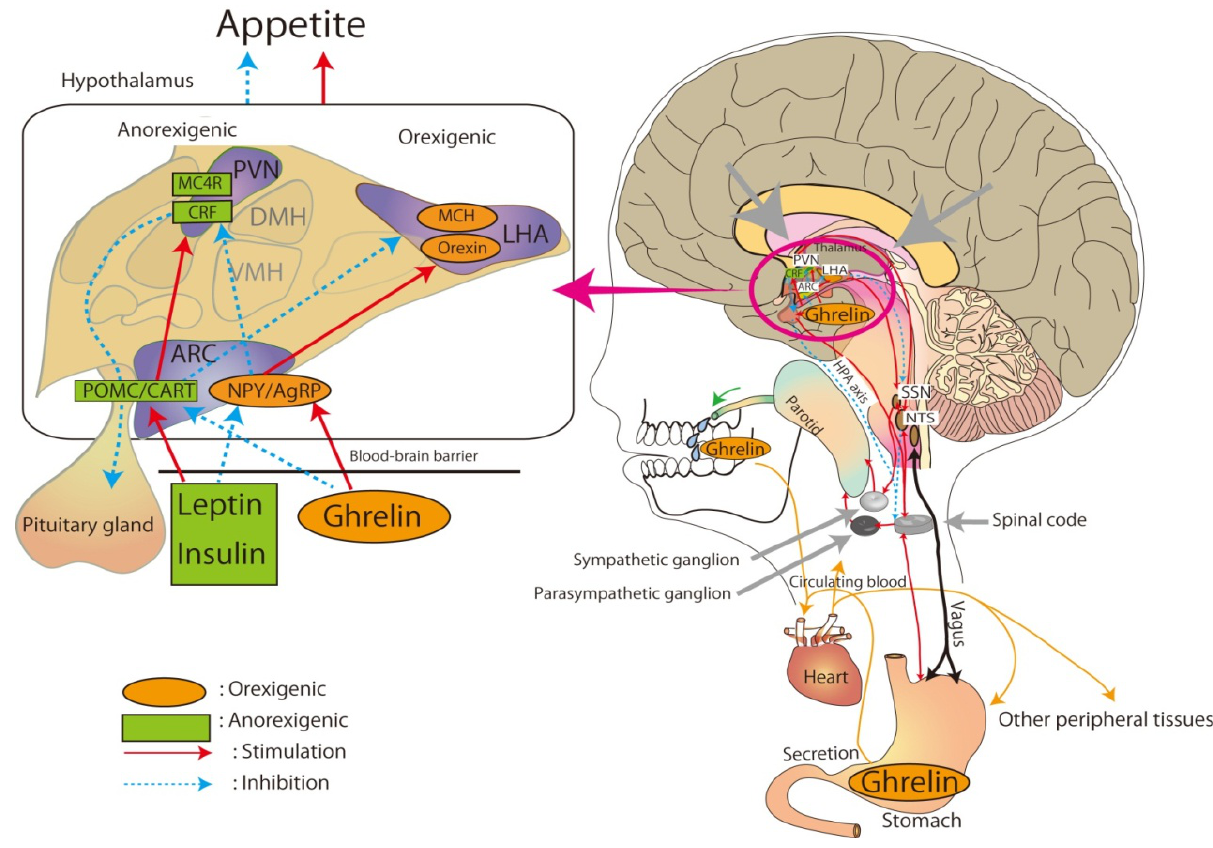
Figure 2. Feeding regulation of neuroendocrine hormones and salivary secretion. Salivary secretion is stimulated through the parasympathetic and sympathetic ganglia. The parasympathetic ganglion receives a stimulus from the nucleus of the solitary tract (NTS), and the sympathetic ganglion receives input from the NTS via the spinal cord. Both ganglia regulate salivary secretions. The parotid salivary glands supply ghrelin. Ghrelin circulates and spreads throughout the human body and brain. Ghrelin acts on specific target tissues. The function of ghrelin is mediated by the autonomic nervous system as well as the hypothalamic–pituitary endocrine axis. Ghrelin affects the metabolic regulation of food intake to achieve homeostasis. This hypothetical feeding regulation model suggests that ghrelin provides a promising pharmacotherapeutic approach for treating eating